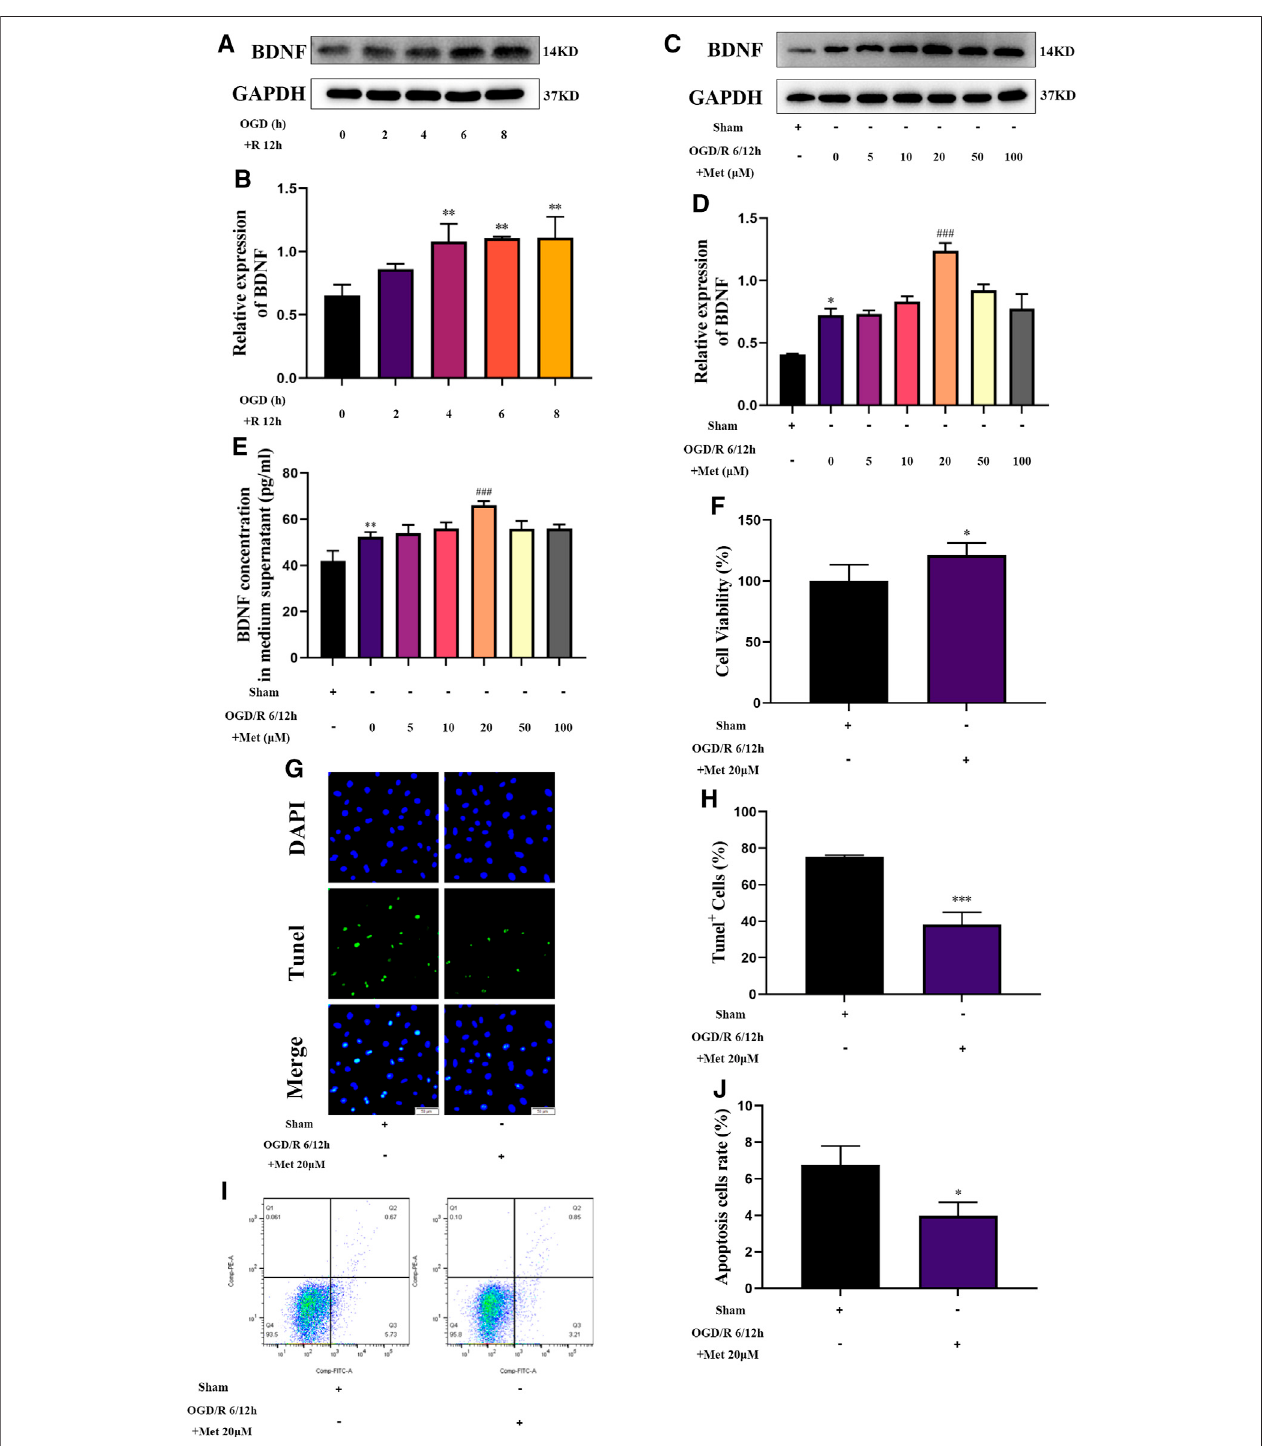
FIGURE5| MetforminupregulatesBDNFexpressionand release,promotesHUVECsproliferation,andinhibitscellapoptosisunderOGD/Rconditions. (A – D) The BDNF expression level of metformin-treated HUVECs was detected by western blotting ( n = 3). (E) The BDNF concentration in the culture supernatant of metformin- treatedHUVECswasdetectedbyELISA( n =3). (F) ProliferationofHUVECswasdetectedbyCCK-8assay( n =5). (G – J) ApoptosisofHUVECswasdetectedbyTUNEL staining ( n = 3, bar = 50 μ m) and fl ow cytometry ( n = 3). (* p < 0.05, ** p < 0.01 vs. sham; # p < 0.05, ### p < 0.001 vs. OGD/R 6/12 h).